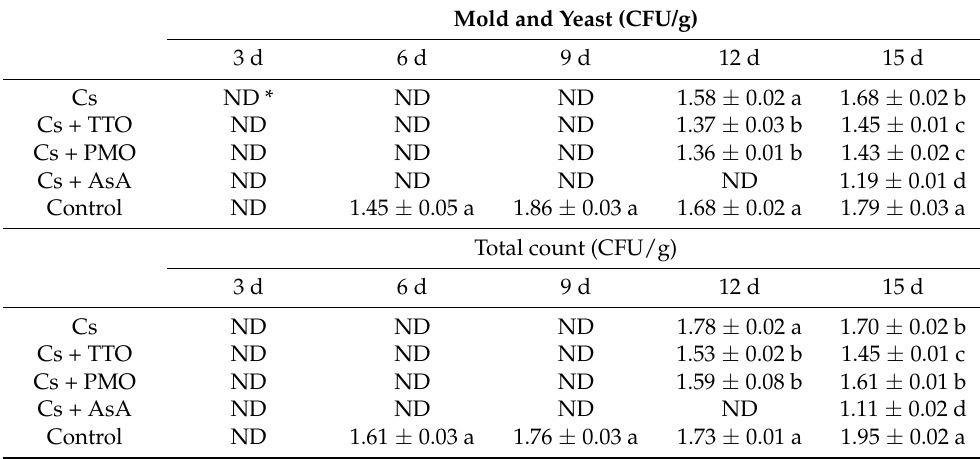
Table 1. Effect of chitosan (Cs), Cs + tea tree oil (TTO), Cs + peppermint oil (PMO), and Cs + ascorbic acid (AsA) on mold and yeast and total count (log CFU/g) of fresh-cut green bean pods stored at 5 °C for 15 d. Data are the average of 3 replicates ± standard errors. Different letters indicate significant differences (Tukey test, p < 0.05%).